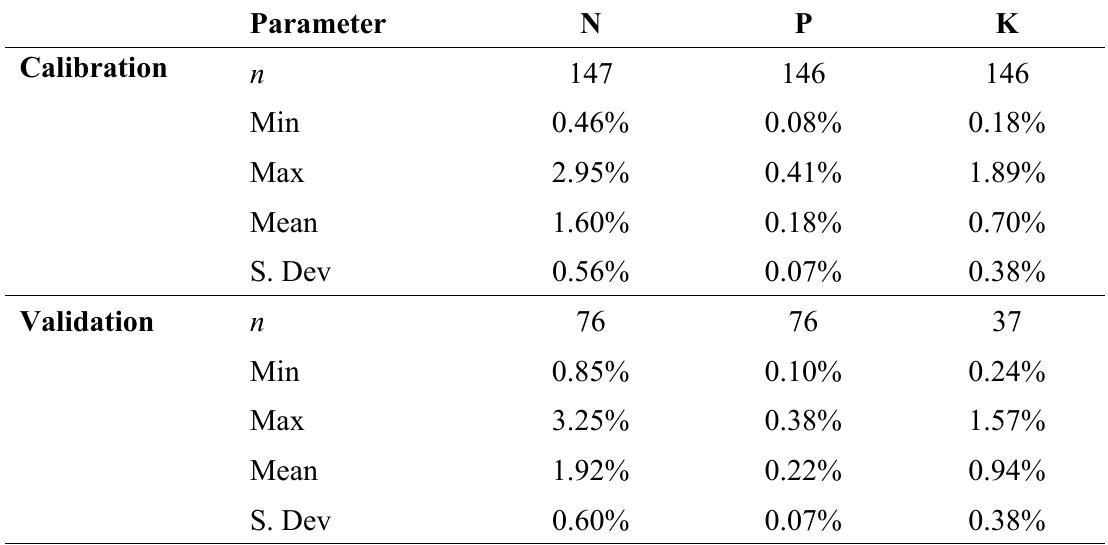
Table 1. Reference data parameters. N, P and K data are shown as percentage of dry matter. Parameter N P K Calibration